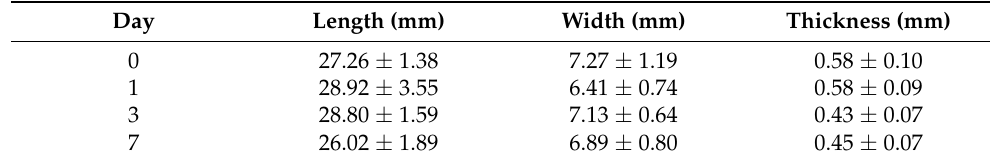
Table 1. Size of CGF membrane at each day.